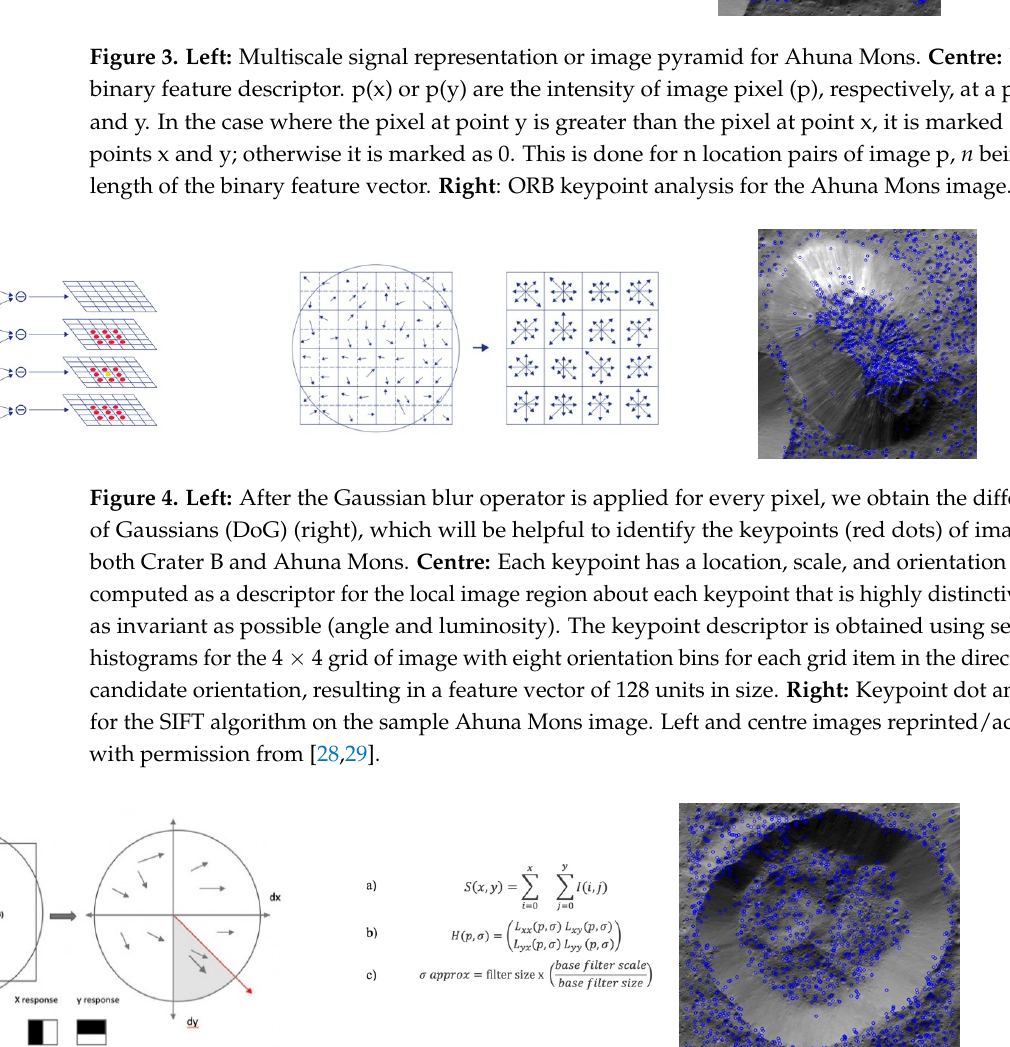
Figure 5. Left: The SURF algorithm has three main parts: point of interest detection, description, and matching. SURF uses square-shaped filters as an approximation of Gaussian smoothing and detects scale invariant points of interest (red dot), and DoG is calculated by rescaling the image progressively. SURF first calculates the Haar-wavelet responses in the x and y directions, in a circular neighbourhood of radius 6 s around the keypoint, with s representing the scale at which the keypoint was detected. Centre: First (top equation) the integral image is used for calculating the sum of values (pixel values) in a given image and represents the sum of all pixels in the input image I within a rectangular region formed by the origin and x. Next, the image is filtered by a Gaussian kernel (middle equation), so, for given a point X = (x, y), the Hessian matrix H (x, σ ) is in x at scale σ . Lxx (x, σ ) is the convolution of the Gaussian second-order derivative with the image I at point x and, similarly, for Lxy (x, σ ) and Lyy (x, σ ). Images are, therefore, repeatedly smoothed with a Gaussian filter and subsampled to the next higher level of the Gaussian pyramid (down equation). Right: Keypoint dot analysis for Crater B.